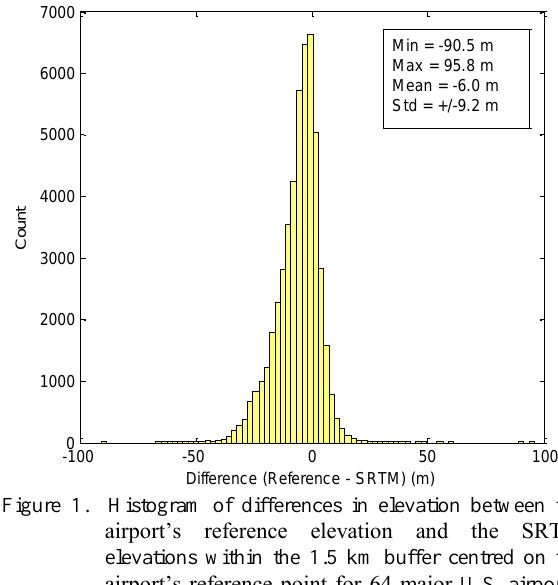
Figure 1. Histogram of differences in elevation between the airport‘s reference elevation and the SRTM elevations within the 1.5 km buffer centred on the airport‘s reference point for 64 major U.S. airports. The mean difference is -6.0 m (the SRTM mean elevation is higher than the reference elevation). The standard deviation is ±9.2 m.